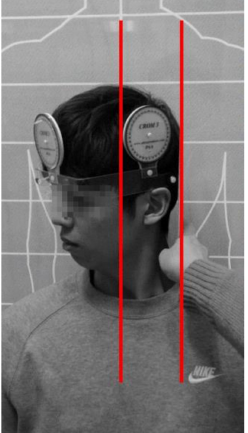
Figure 3. Upper cervical rotation-flexion